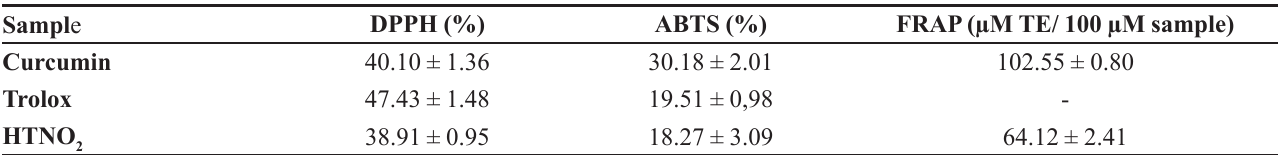
SCHEME 1 - Synthetic route for the preparation of hydrazine-thiazole HT-NO TABLE I - Comparison of the results obtained for the in vitro antioxidant assays: DPPH radical scavenging assay; ABTS